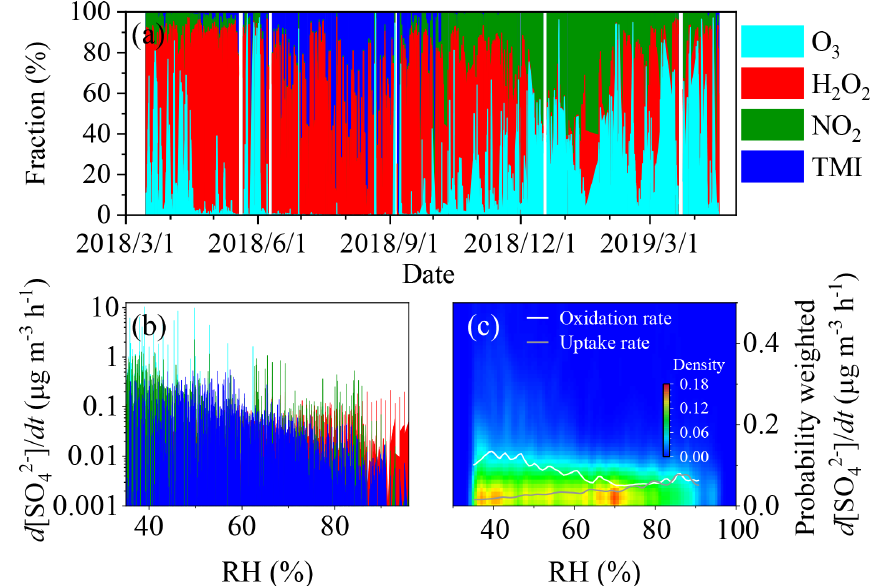
Figure 4. (a) The relative importance of oxidation paths of S(IV) in aqueous phase, the dependence of (b) sulfate formation rates and (c) the probability-weighted sulfate formation rates on RH in